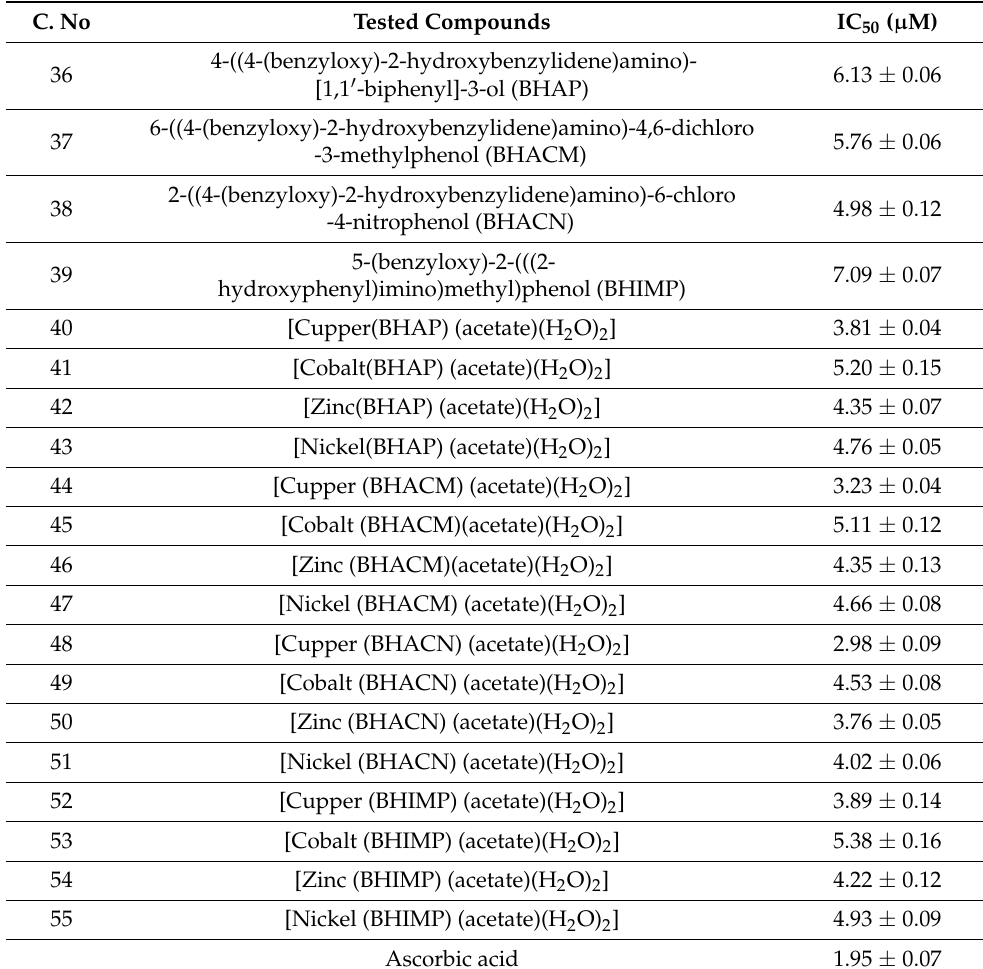
Table 4. In vitro DPPH scavenging capacities (IC 50 , µ M) of reference drugs, ligands, and their metal (II) chelates (36–55)